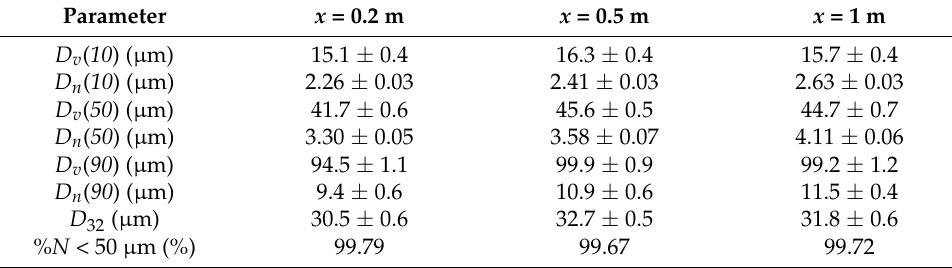
Table 2. The results obtained during the measurements for the F2 ceramic